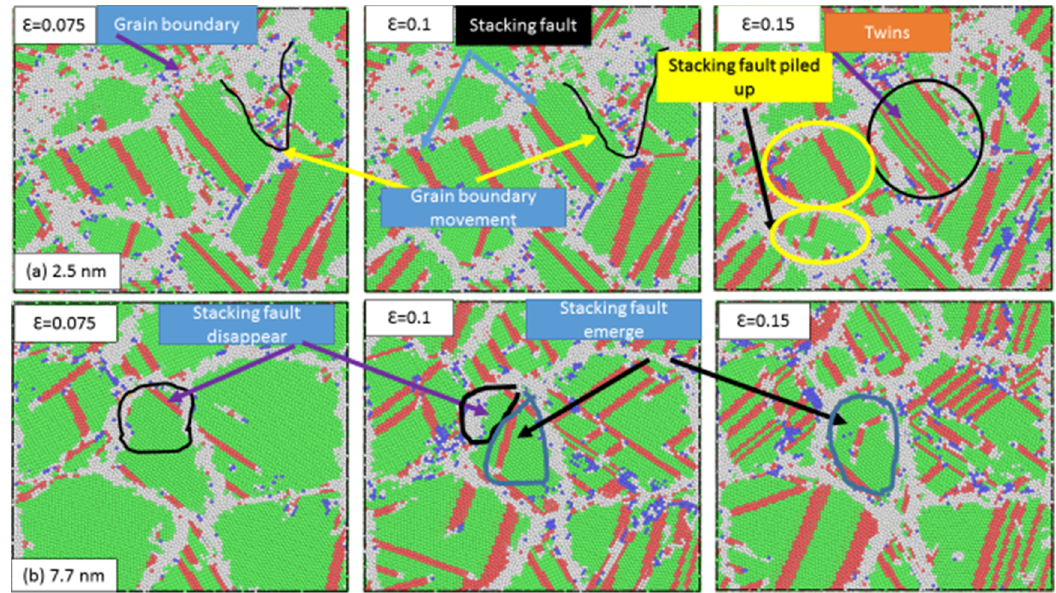
Figure 4. Twins and dislocations (accumulation and disappearance) in the samples with grain sizes of ( a ) 2.5 nm and ( b ) 7.7 nm during various stages of plastic deformation (ε = 0.075, ε = 0.1, and ε = 0.15).